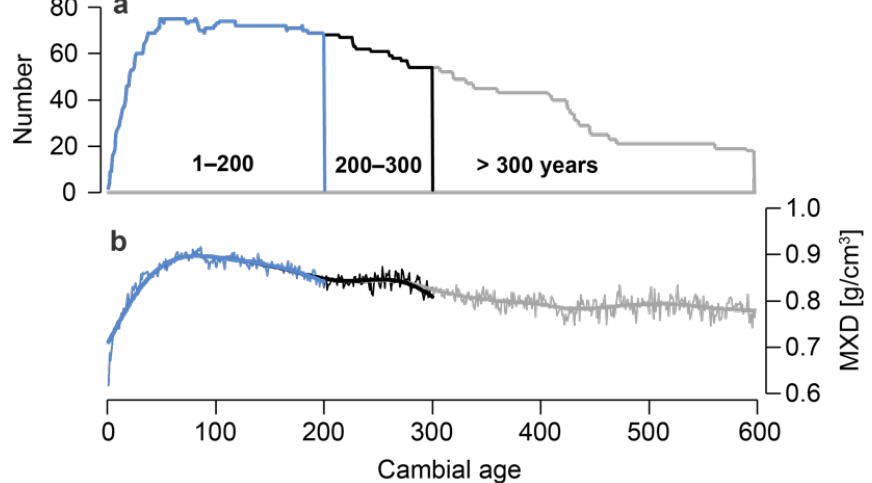
Figure 2. Replication and regional curves (RCs) of the combined Cazorla MXD data. ( a ) The number of MXD series after aligning the data by cambial age. Rings younger than 200 years highlighted in blue, from 200 to 300 years in black, and older than 300 years in gray. ( b ) The RCs of the three age bands. Thick curves are 100-year low pass filters.